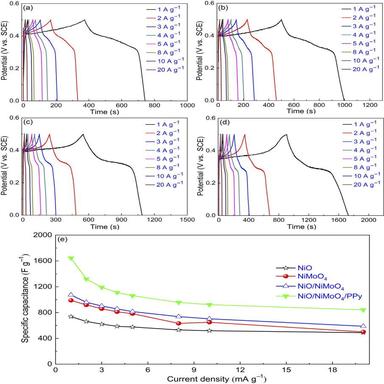
(Color online) GCD curves of NiO (a), NiMoO4 (b), NiO@NiMoO4 (c), NiO@NiMoO4@PPy (d) at various current densities and specific capacitances of as-prepared electrode materials calculated by GCD curves (e).